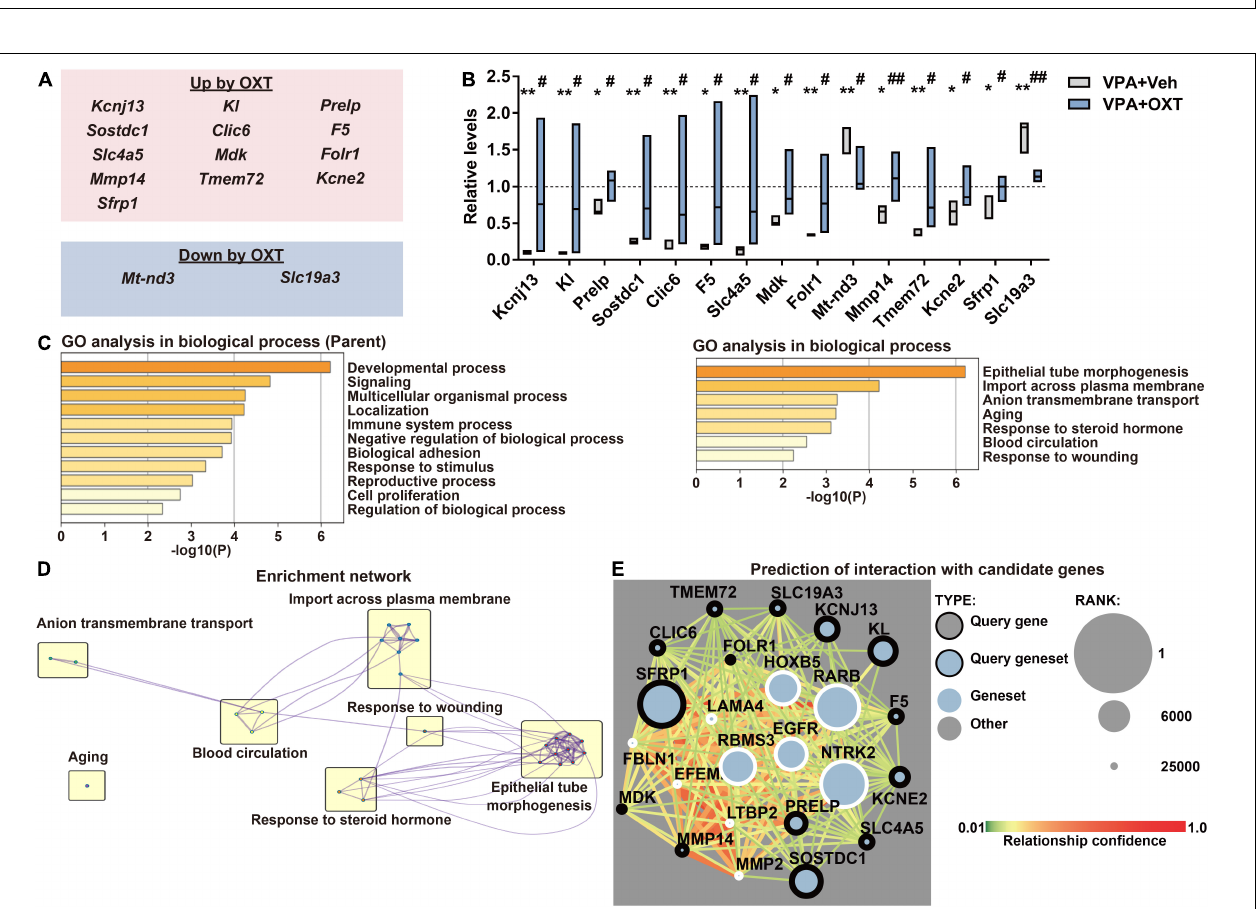
FIGURE 3 | Effect of chronic treatment of intranasal OXT on prenatal VPA exposure-induced molecular changes. (A) Summary of (top) upregulated and (bottom) downregulated DEGs by OXT (12 µ g/kg/day). (B) Quantification of expression levels of genes improved by OXT. The levels were normalized to those of the control. The top and bottom of the bar depict the highest and the lowest of values, respectively. The line within the bar shows the median ( n = 3 per group). * P < 0.05 and ** P < 0.01 vs. control; # P < 0.05 and ## P < 0.01 vs. vehicle-treated VPA. (C) Biological processes of DEGs in GO enrichment analysis. Left, parent; Right, child annotations, respectively. (D) Enrichment networks between clusters of biological processes with child annotations. (E) Predictive interaction between DEGs improved by OXT and ASD candidates in Krishnan’s database. Shown are top 10 of candidates connecting strongly with our gene sets. DEG, differentially expressed gene; OXT, oxytocin; GO, gene